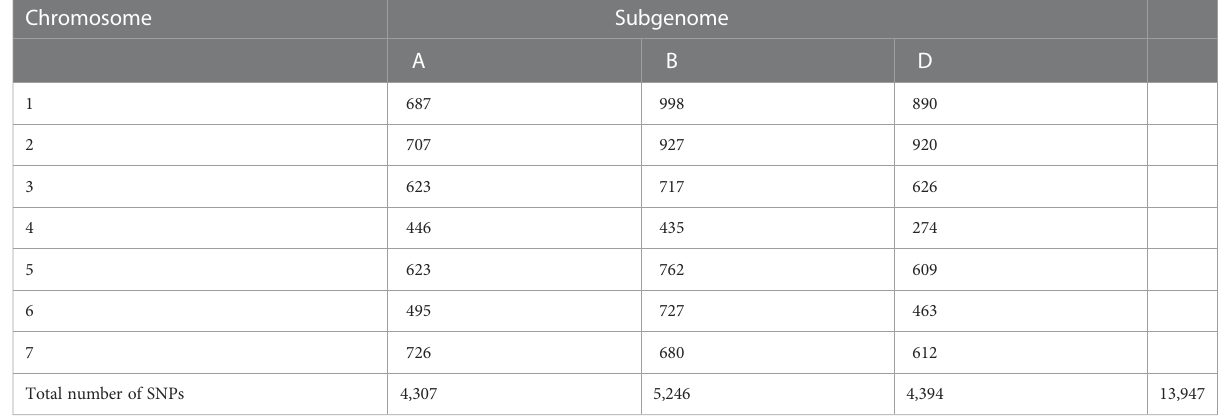
TABLE 3 Distribution of 13,947 fi ltered SNPs over chromosomes and three subgenomes A, B, and D. Chromosome